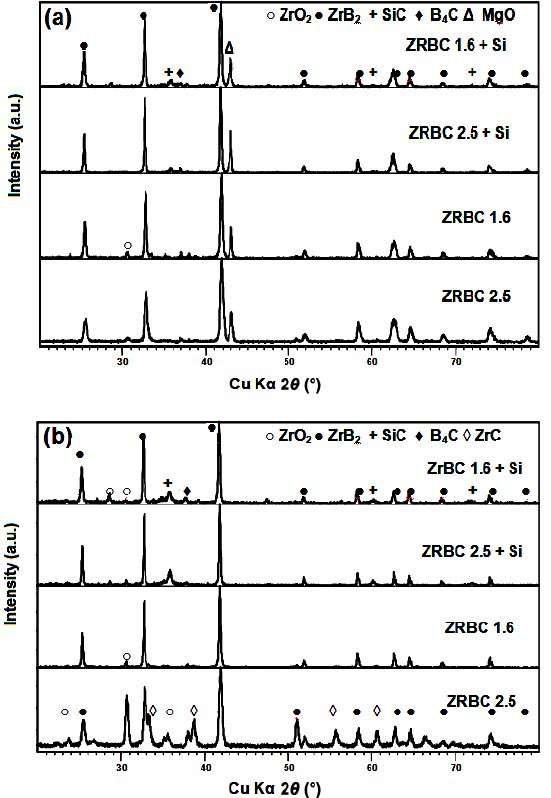
Fig. 4 XRD patterns of ZRBC samples (a) after FT assisted reaction and (b) after leaching with HCl acid.